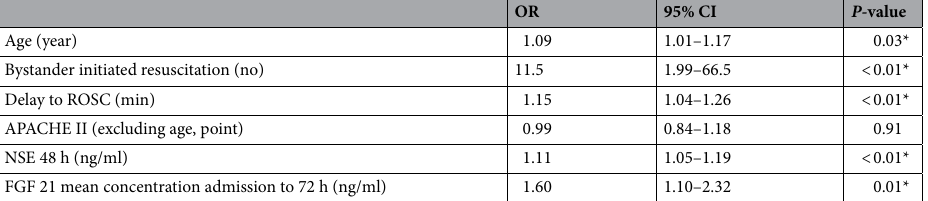
Table 4. Logistic regression model for predicting 6-month poor neurological outcome (CPC 3–5). Good outcome, 6-month Cerebral Performance Categories (CPC) 1–2 (neurological condition ranging from “good cerebral performance” to “moderate cerebral disability”); Poor outcome, 6-month CPC 3–5 (neurological condition ranging from “severe cerebral disability” to “death”); OR, odds ratio; CI, confidence interval. *Statistically significant at the P < 0.05